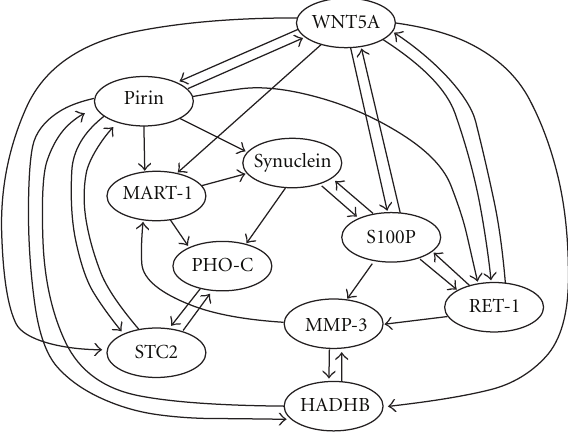
Figure 3: Structure of WNT5A network